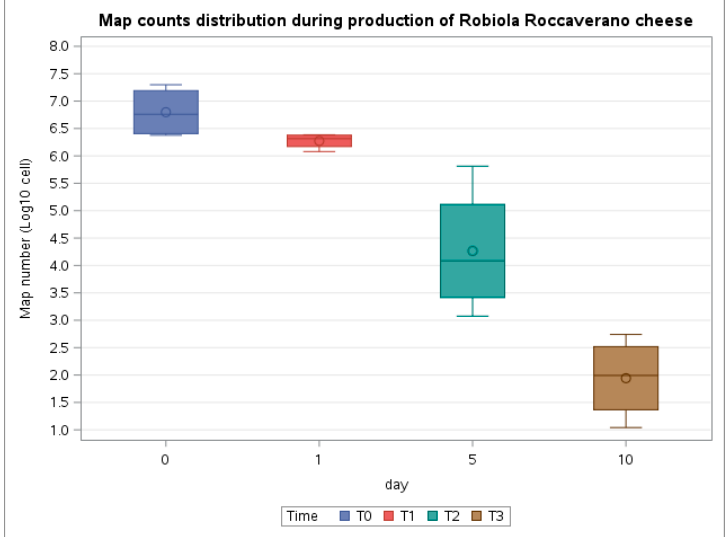
Figure 2. Boxplots displaying the MAP count distribution during the production of Robiola di Roccaverano cheese. The MAP count was performed by qPCR at four time points (T0–T3). Wilcoxon test showed a significant difference between MAP median value at T0